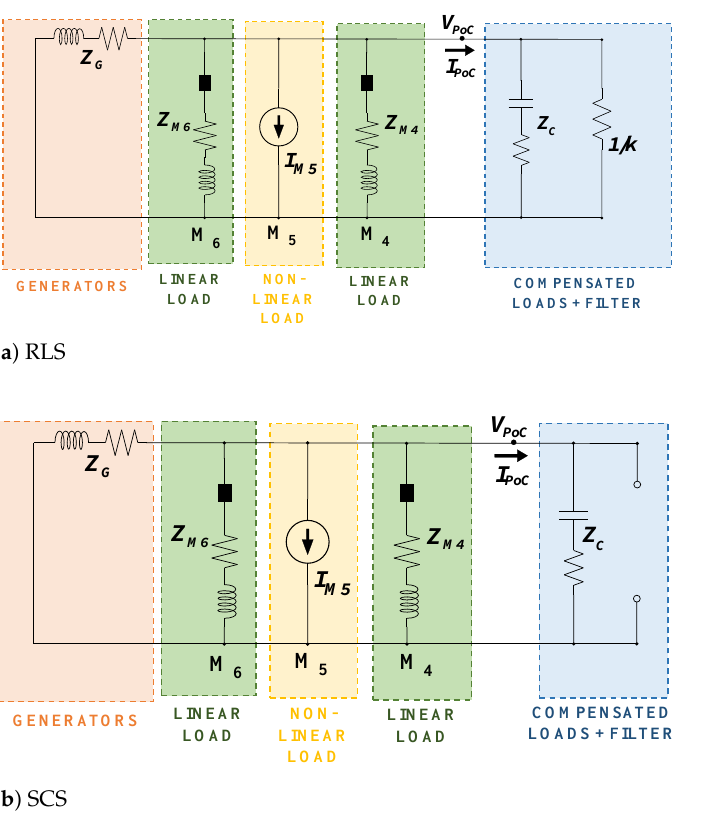
Figure 6. Equivalent circuit model for the frequency components superior to the fundamental one: ( a ) RLS and ( b )